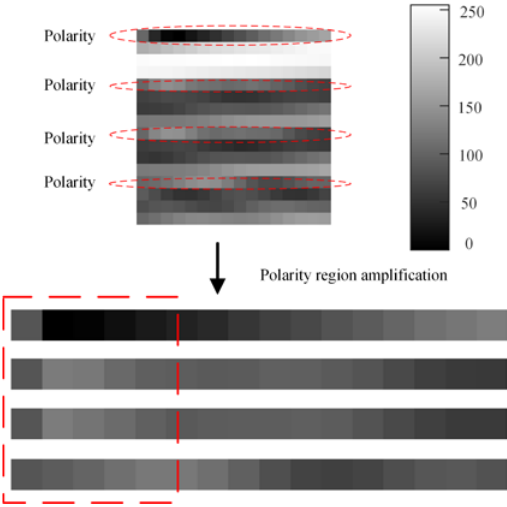
Figure 8. Polarity feature analysis diagram of grayscale image of system fault.